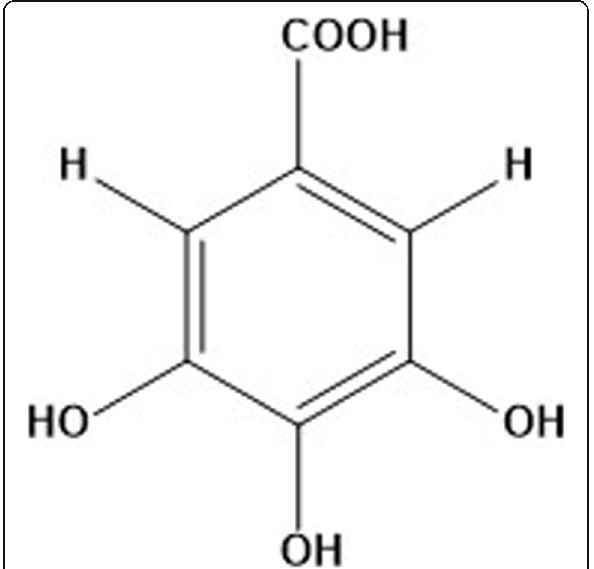
Fig. 1 Chemical structure of gallic acid (3,4,5-trihydroxybenzoic